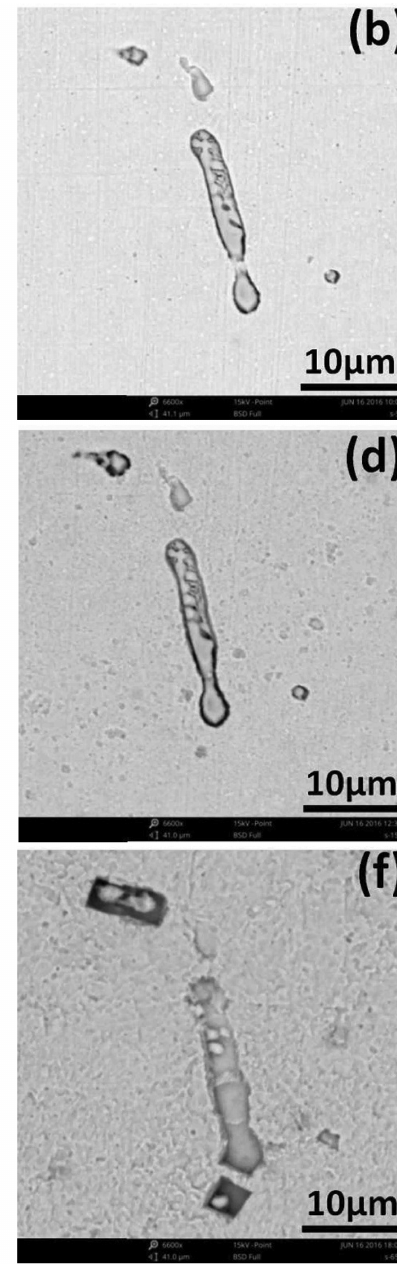
Figure 8: Different corrosion Morphology of MnS inclusions in different times. (a) 0 s; (b) 5 s; (c) 10 s; (d) 15 s; (e) 35 s; (f) 65